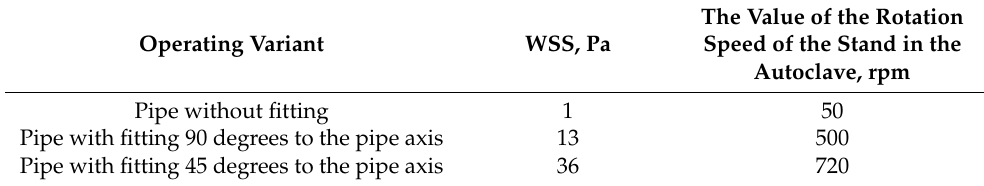
Table 4. The values of the maximum (local) WSS for various operation options.